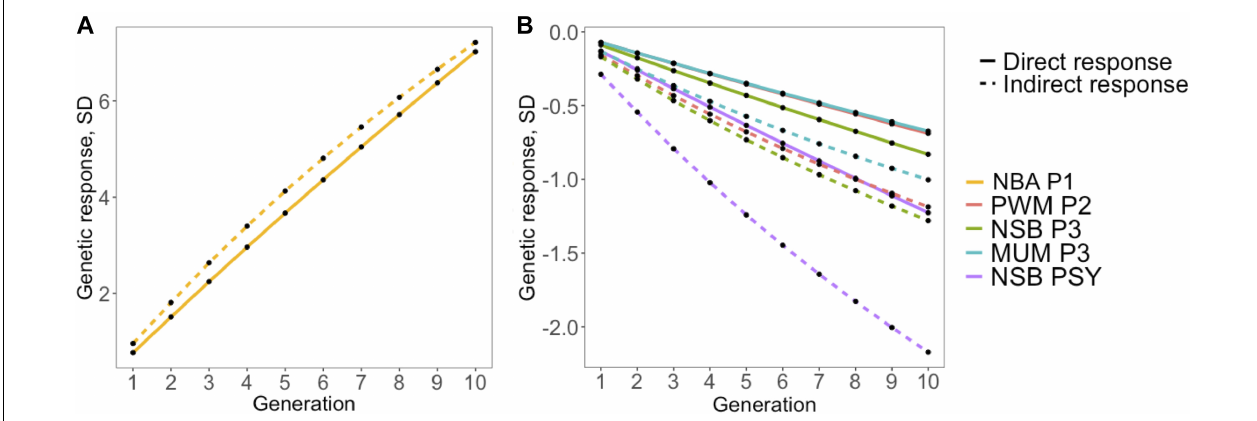
FIGURE 4 | Simulated response to selection for reproductive performance after 10 generations based (indirect) or not (direct) on antibody response, measured as sample-to-positive (S/P) ratio, to porcine reproductive and respiratory syndrome virus vaccination. The y - and x -axes represent response to selection in genetic standard deviations and generations, respectively. Direct and indirect response to selection is represented by solid and dashed lines, respectively, assuming 5% selection intensity. Colors represent (A) number born alive at first parity at first parity (NBA P1; golden), (B) pre-weaning mortality at second parity (PWM P2; coral), number of stillborn (NSB) at third parity (NSB P3; green), number of piglets mummified at third parity (MUM P3; blue), and NSB per sow per year (NSB PSY; purple).